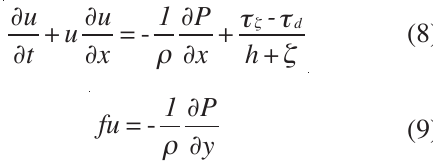
(t) vs u (t) l l (t) (dotted line). Spectral l